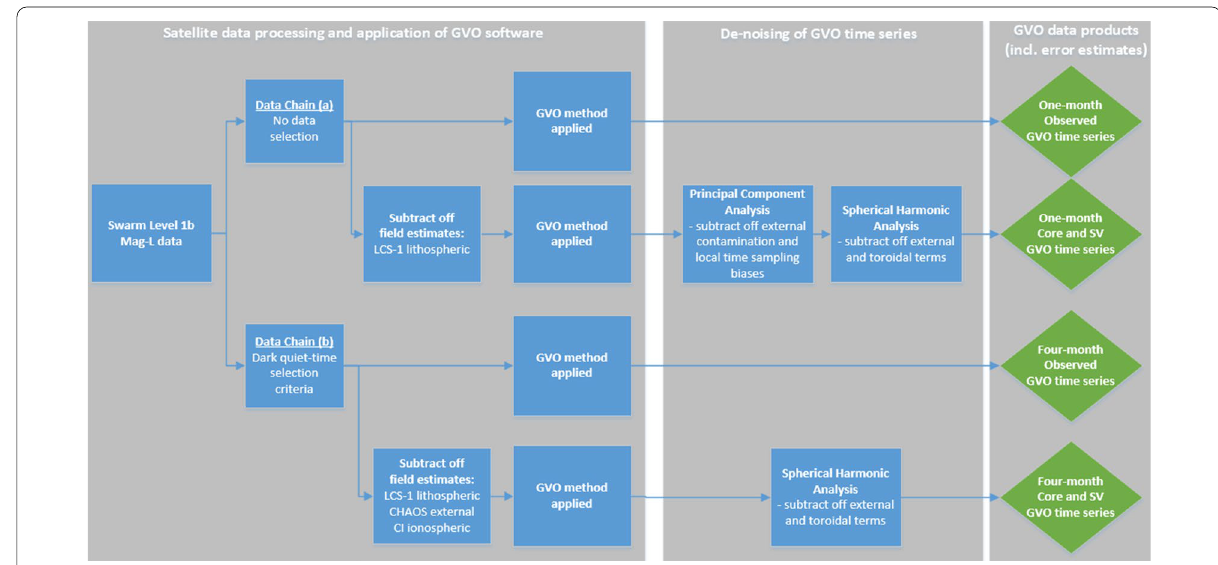
Fig. 2 Overview of the Swarm GVO data product processing and model estimation